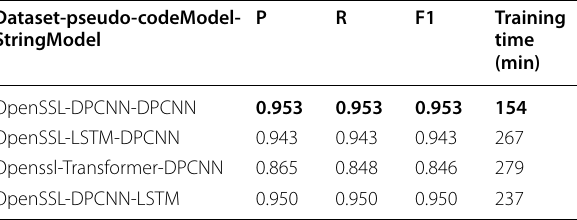
Table 2 UPPC uses semantic classification results from different deep learning models and their combinations Dataset‑pseudo‑codeModel‑ StringModel